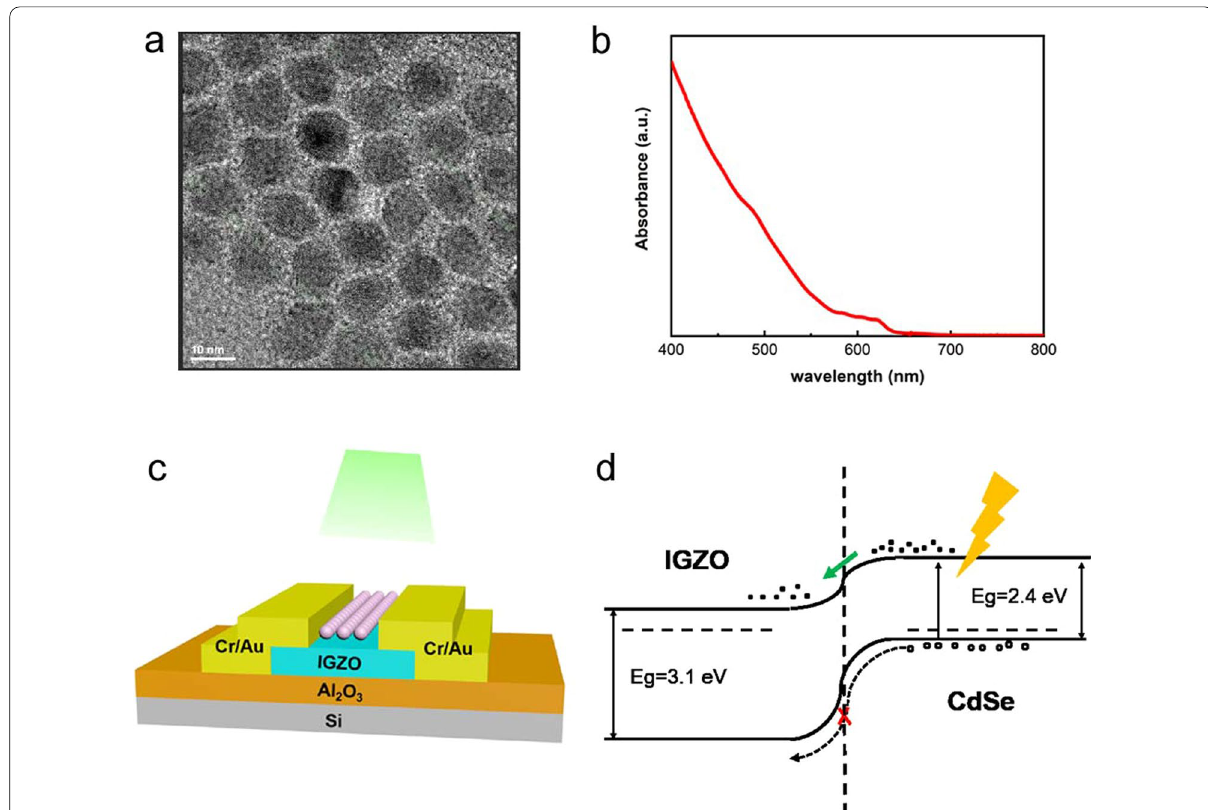
Fig. 1 a HRTEM image of the CdSe QDs, b UV–vis absorption spectrum of CdSe QDs, c schematic diagram of the phototransistor with CdSe QDs/a‑IGZO hybrid channel, d band diagram of the CdSe QD/a‑IGZO hybrid